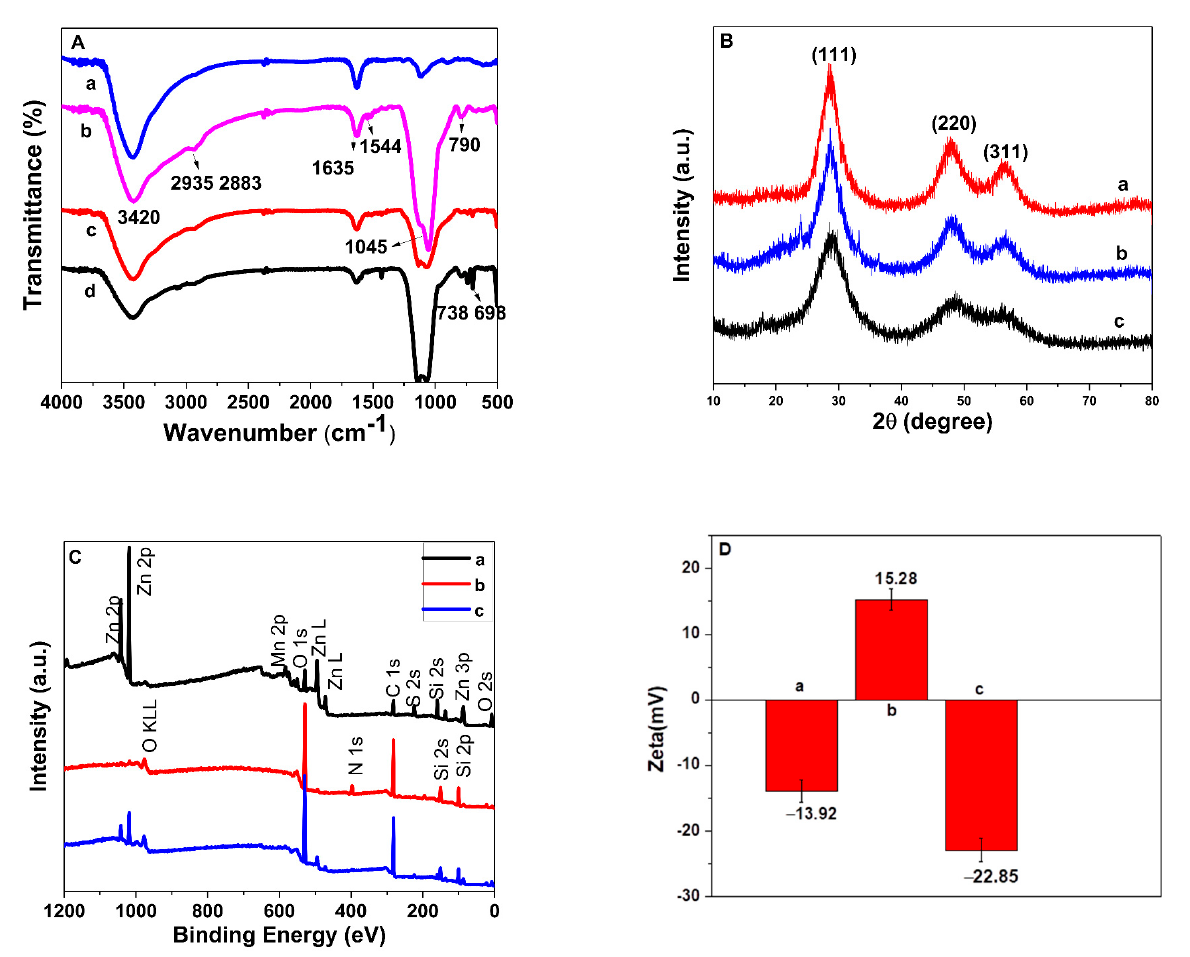
Figure 4. ( A )FT-IR of MPTS@Mn-ZnS QDs (a), APTES@Mn-ZnS QDs (b), MIPs@Mn-ZnS QDs (c) and NIPs@Mn-ZnS QDs (d). ( B ) The XRD patterns of MIPs@Mn-ZnS QDs (a),